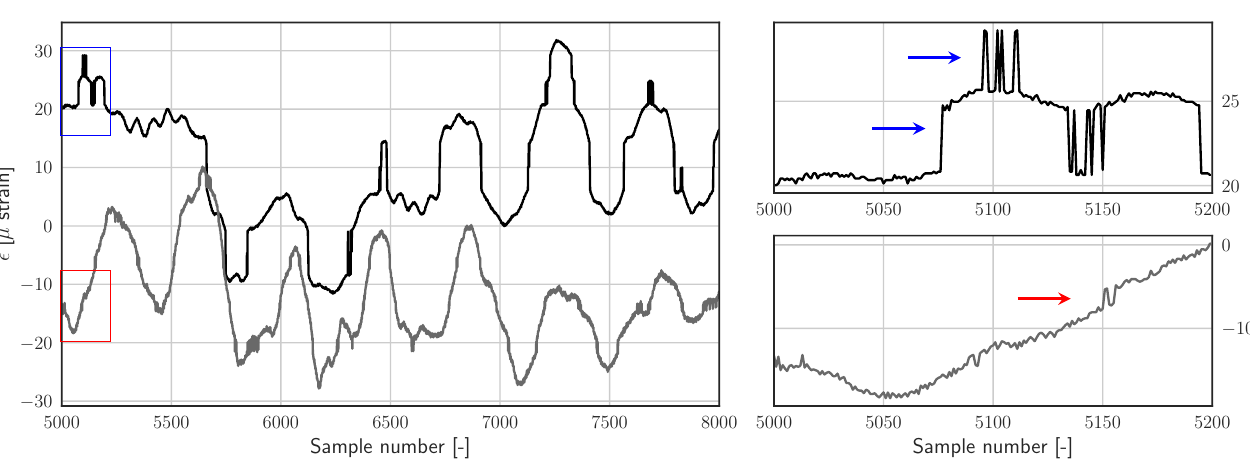
Figure 2. Left : two examples of raw strain measurements clearly showing peak switching artefacts as jumps which offset parts of the signal as well as spikes. Right : the top and bottom figures show zoomed-in views of the blue and red rectangles, displaying jumps in the separable and overlapping data set, respectively.